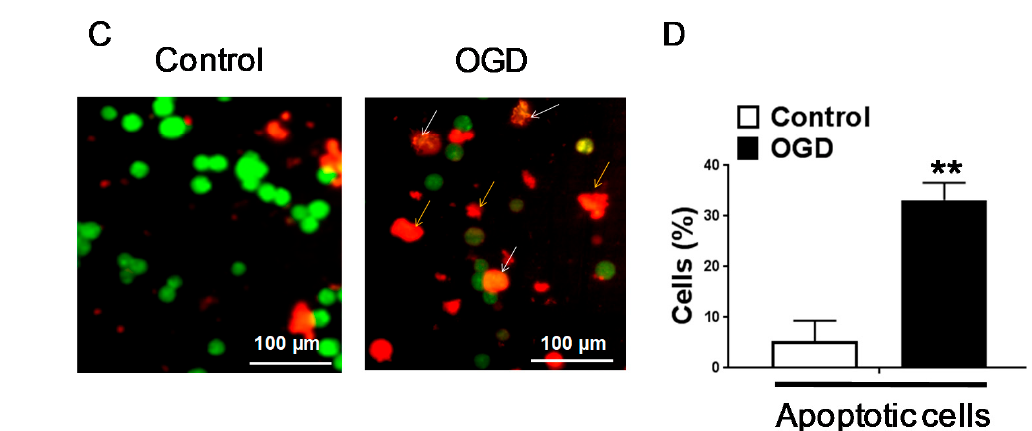
Figure 1. Cell Viability, toxicity, and morphological changes in di ff erentiated SH-SY5Y cells following oxygen-glucose deprivation (OGD) exposure. ( A ) Assessment of SH-SY5Y cell survival following exposure to OGD was measured by Cell Counting Kit-8 (CCK-8) assays. ( B ) Assessment of cell injury by lactate dehydrogenase (LDH) assay. Cells were exposed to OGD for various time intervals. ( C ) Di ff erentiated SH-SY5Y cells stained with a combination of acridine orange (100 µ g / mL): ethidium bromide (100 µ g / mL) 1:1 ratio. For OGD treatment, cells were exposed to 4 h of OGD. The white arrow shows necrosis and the yellow arrow show apoptotic cell death. ( D ) Representative graph showing the percentage of live cells and apoptotic cells control vs. OGD. Images were captured by an inverted fluorescent microscope (Nikon Instruments Inc., Tokyo, Japan) at 40 × magnification. Six independent microscopic fields were selected for each experiment, and the data were expressed as mean ± SD for three independent experiments. Values were expressed as a percentage of the control. The data were expressed as the mean ± SD of three experiments. * p ≤ 0.05, ** p ≤